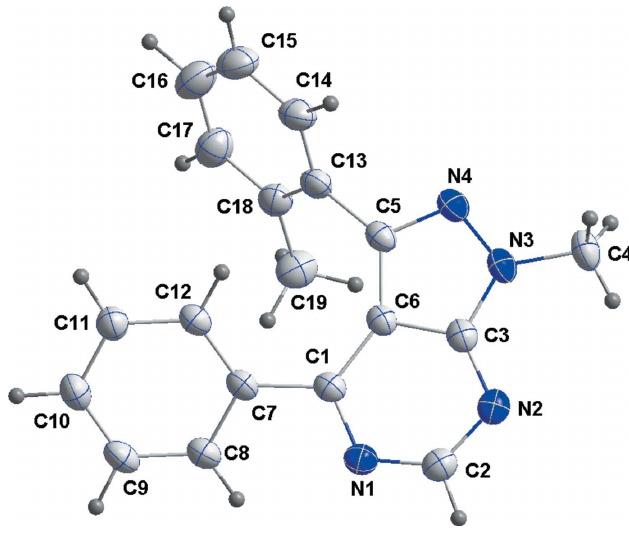
Figure 1 The molecular structure of the title molecule, with the atom-labelling scheme and displacement ellipsoids drawn at the 50% probability level.